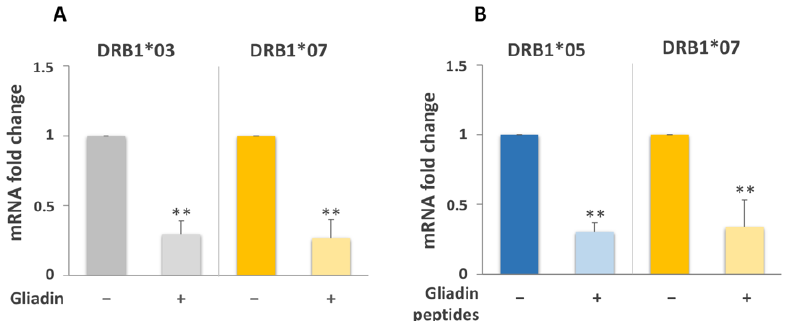
Figure 6. Expression of DRB1 alleles. ( A ) Gliadin stimulation induced a 3.4 and 3.8-fold decrease of DRB1*03 and DRB1*07 mRNAs, respectively, in the M Φ of CD patients with the DR3/DR7 genotype ( n = 4: CD20, CD25, CD31, and CD35). ( B ) M Φ of DR5/DR7 patients showed a 3.3 and 3-fold decrease of DRB1*05 and DRB1*07 mRNAs, respectively, after gliadin peptides stimulation ( n = 5: CD07, CD11, CD21, CD26, and CD55). (** p <